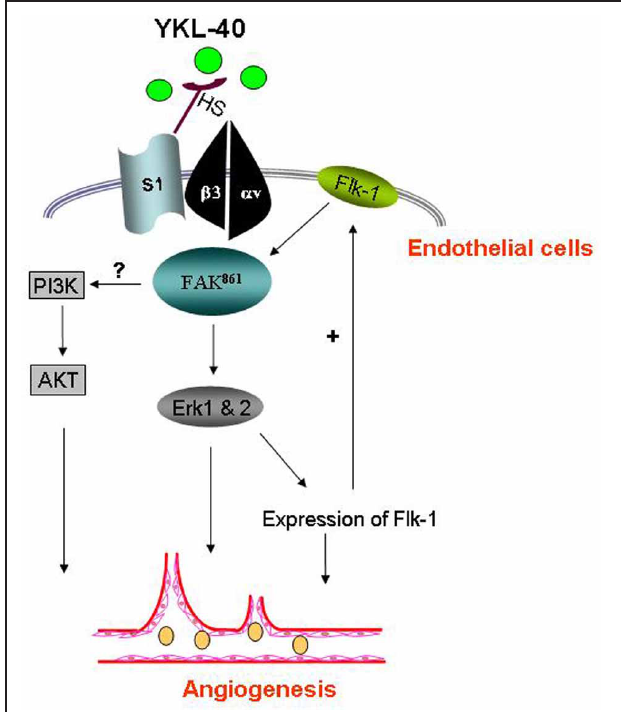
FIGURE 2 | YKL-40 induces angiogenic signaling in endothelial cells. YKL-40 induces the coordination of syndecan-1 (S1) and integrin α v β 3 through binding heparan sulfate chains (HS) of S1 on cell surface. The intracellular signaling pathway includes pFAK 861 and downstream MAP kinase Erk 1 and 2, leading to angiogenic responses and angiogenic gene expression as well (e.g., Flk-1). Flk-1 up-regulation in turns activates the signal transduction cascade, constituting a positive feedback loop to enhance angiogenic responses. Elevated Flk-1 may also sensitize angiogenic responses to VEGF. An additional PI3K-AKT pathway participating in YKL-40-induced angiogenesis in endothelial cells warrants further